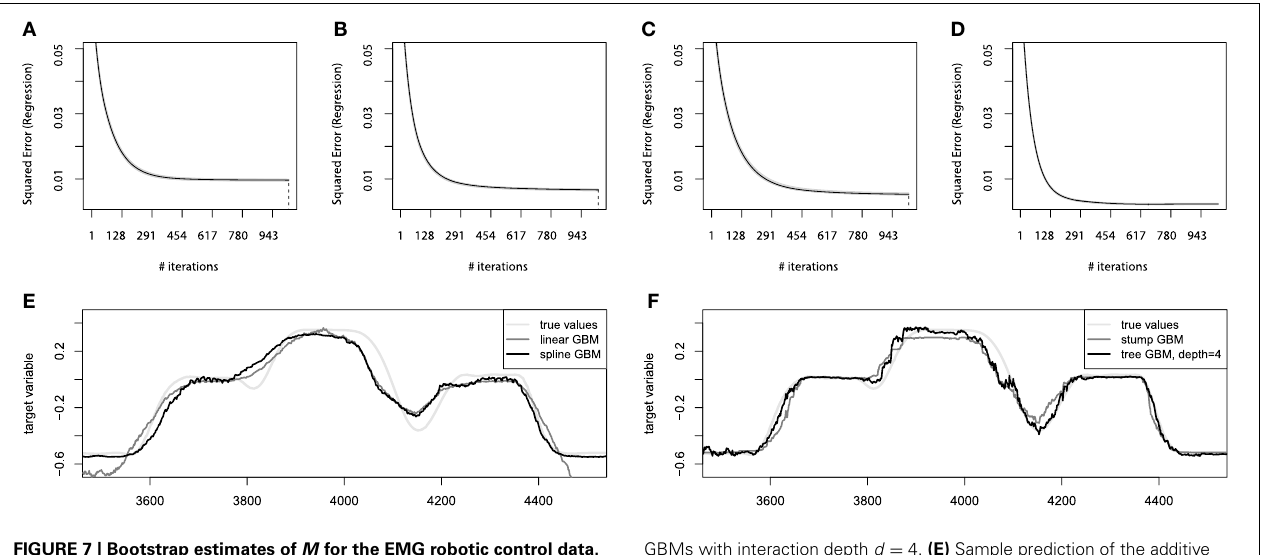
FIGURE 7 | Bootstrap estimates of M for the EMG robotic control data. (A) Held-out error for linear GBMs; (B) held-out error for spline GBMs; (C) held-out error for stump-based GBMs; (D) held-out error for tree-based